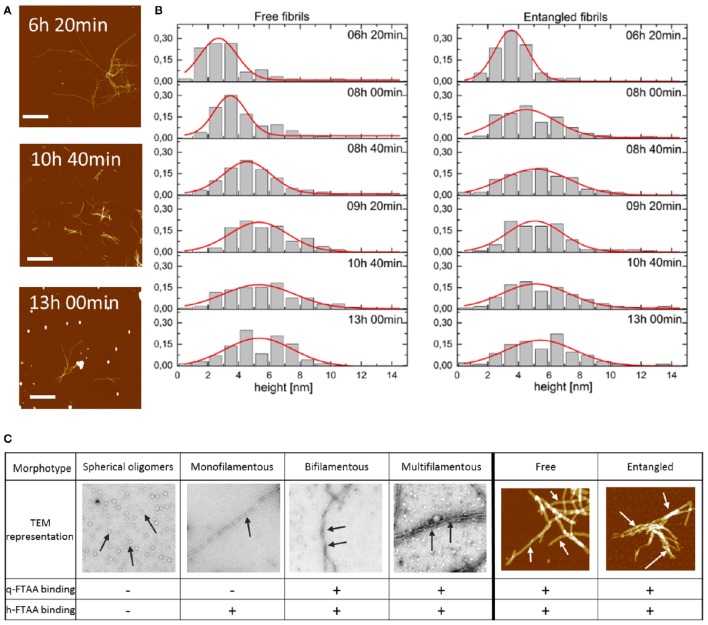
(A) AFM topographs presenting the fibrils in the process of Aβ1-40 fibrillation at the different time points. Scale bar represents 2 μm. Maximum height was chosen to be 20 nm to make the aggregated fibrils visible. (B) Distribution of the height of free and entangled fibrils of Aβ1-40 for consecutive time points of the fibrillation. Red lines represent Gaussian distribution fits to derive an average height of the fibrils. (C) Morphotypes of Aβ aggregates as depicted by TEM or AFM and indicated by arrows and their hypothesized binding propensity toward q-FTAA and h-FTAA, respectively.